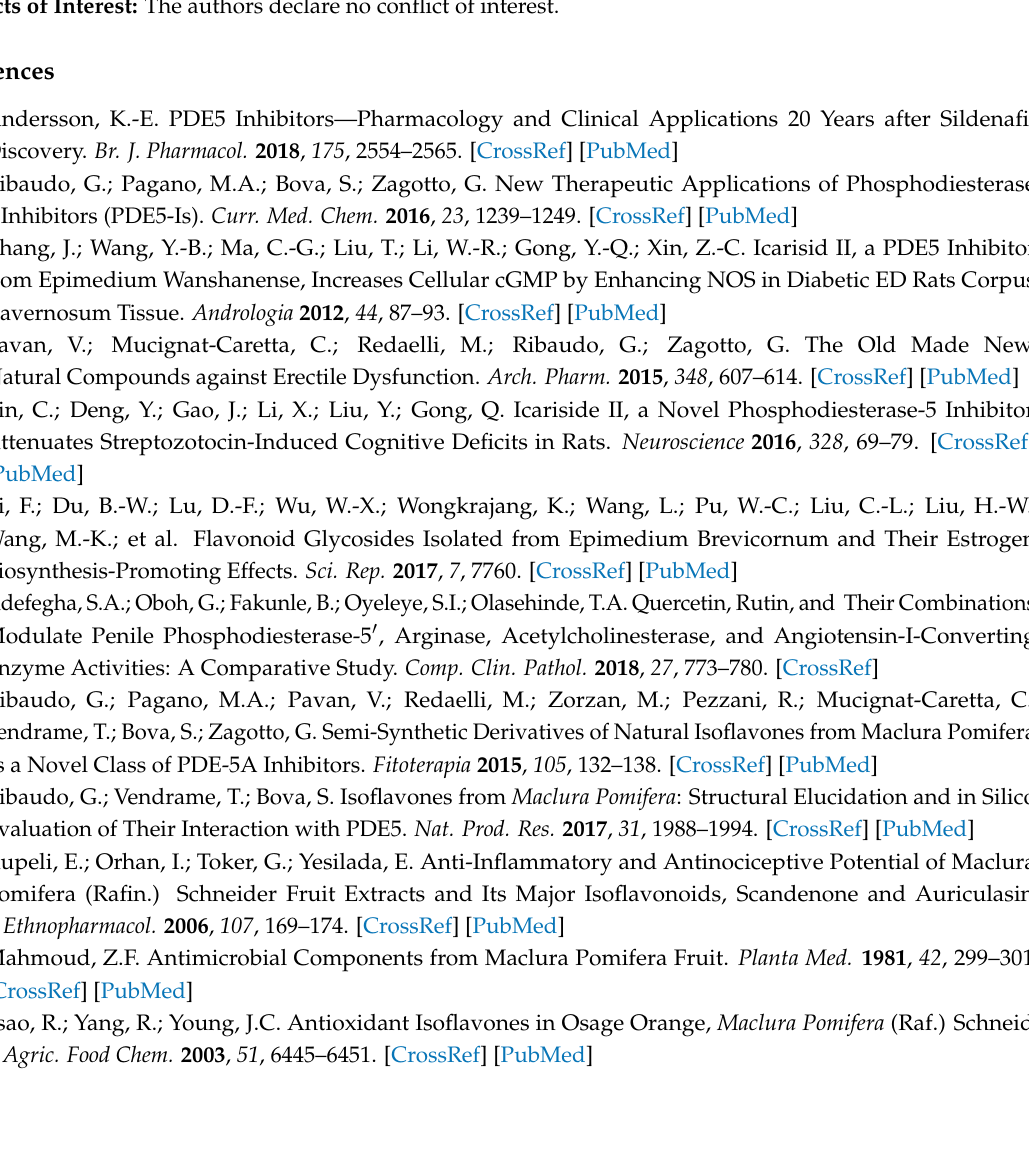
Figure S11: mass spectrum, Figure S12: HPLC chromatogram, Figure S13: UV spectrum, Figure S14: molecular docking, Table S1: molecular docking